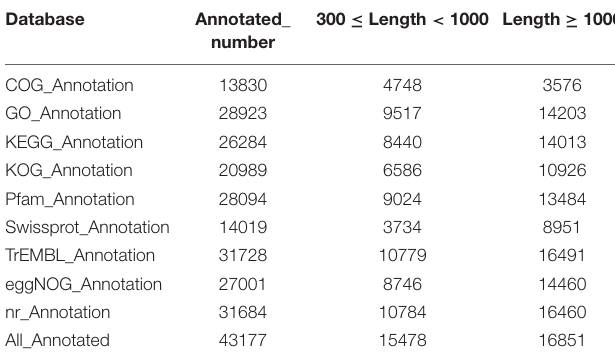
TABLE 3 | The unigene’s annotation statistics in spleen of hybrid grouper fed fresh fish oil (R group) and highly oxidized fish oil (H group). Database